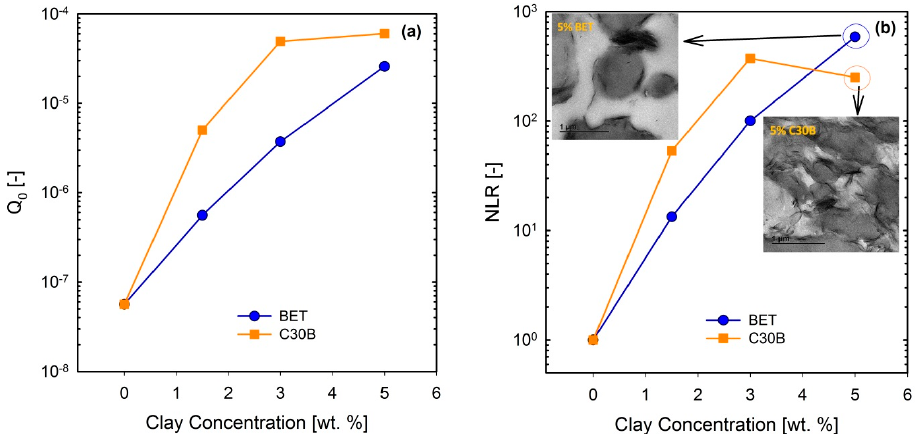
Figure 14. ( a ) Q 0 and ( b ) NLR values for the (60/40) PLA/PBS/0.6J blends filled with C30B and BET organoclays, for different loadings. Inset images in ( b ) are TEM images of 5 wt % blends of their corresponding blend. BET is Betsopa™, C30B is Cloisite ® 30B, and J is Joncryl.